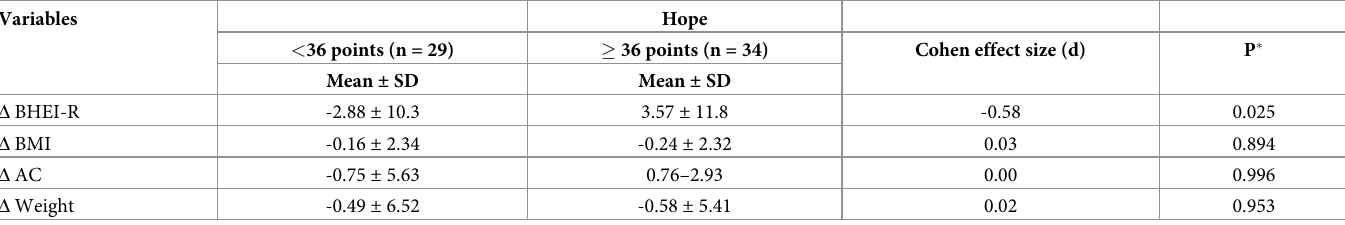
Table 8. Classification of hope (dichotomized at the median) associated with the BHEI-R, BMI, AC and weight of patients with metabolic syndrome, Porto Alegre, Brazil (n = 63).